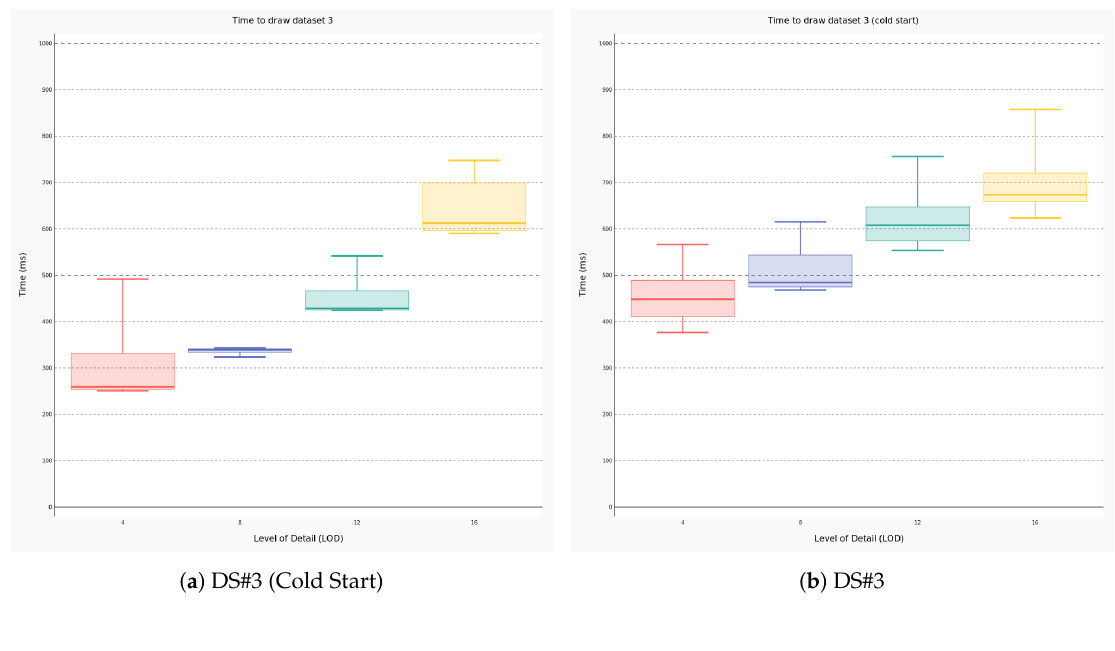
Figure 20. Time to represent DS#3.